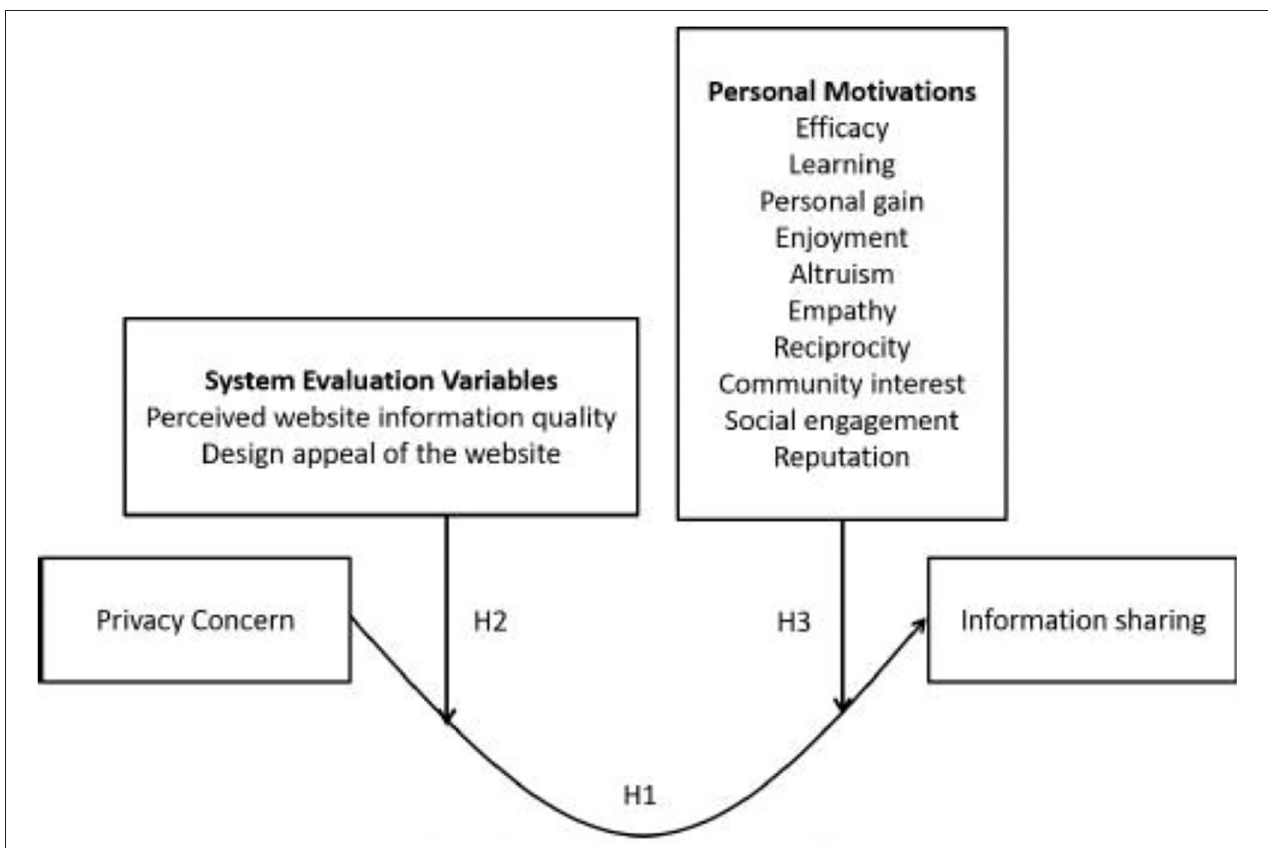
FIGURE 1 | Research